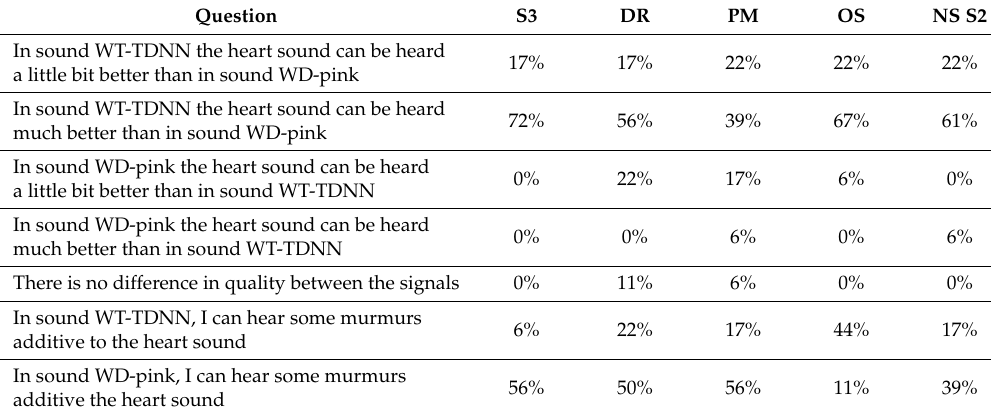
Table A1. Comparison of WT-TDNN with WD-pink.